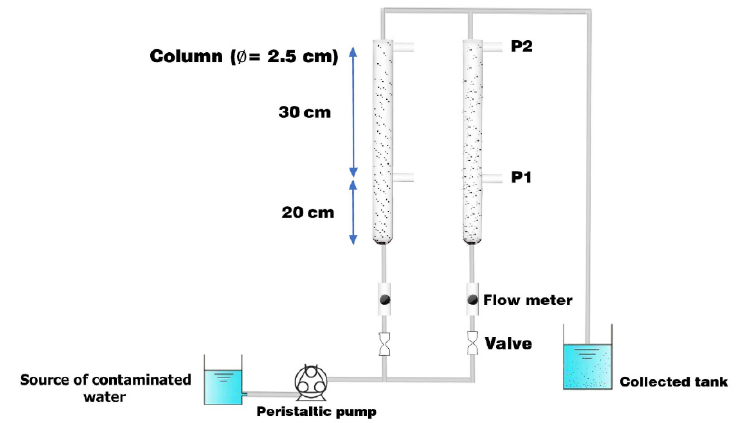
Figure 9. Components of laboratory set-up for continuous mode operation.